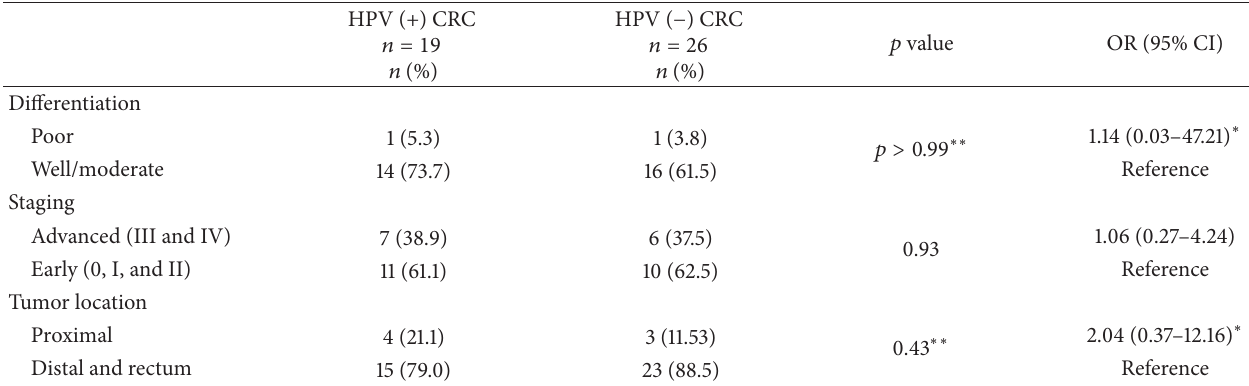
Table 4: Clinicopathological characteristics of colorectal tumors according to HPV